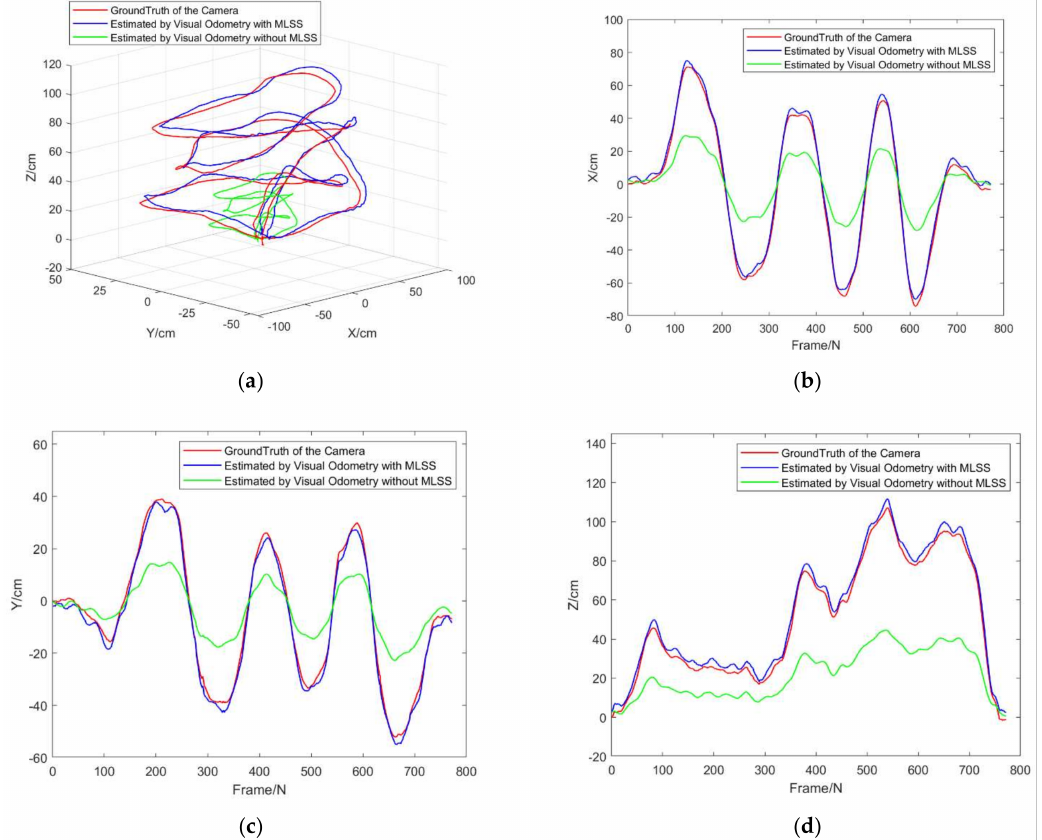
Figure 16. Camera localization experiment: Red represents ground truth measured by motion capture system, blue represents the camera motion trajectory estimated by MLSS − VO, and green represents the camera motion trajectory estimated by the traditional feature point method: ( a ) comparison of three − dimensional trajectories; ( b ) comparison of x -axis; ( c ) comparison of y -axis; ( d ) comparison of z